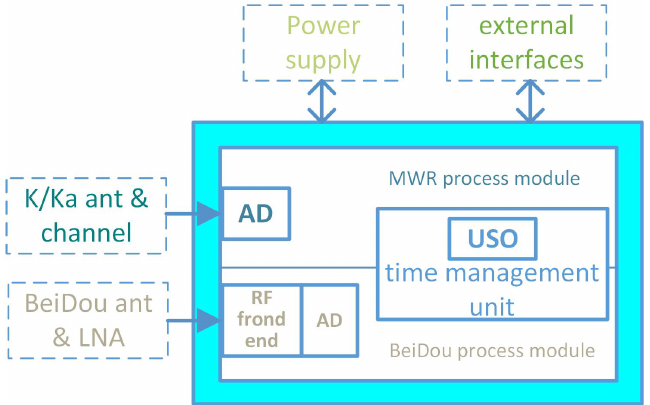
Figure 4. Principle block diagram of integrated signals process hardware platform, including K/Ka band dual frequency MWR process module, BeiDou III B1C/B2a dual frequency navigation process module and external interface